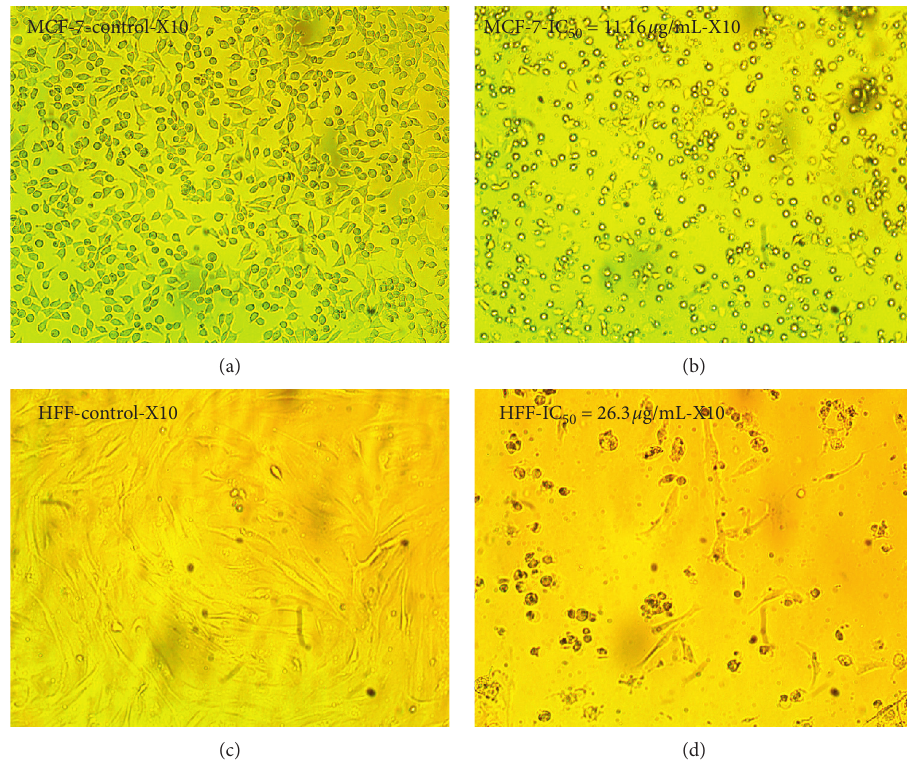
Figure 3: Morphological alteration of cancer cells exposed to the IC 50 (24h) concentration of ZnO-NPs compared with the control. (a) Untreated MCF7 cells. (b) Morphology of the MCF7 cells after ZnO-NP treatment with IC 50 dose (IC 50 � 11.16 μ g/mL). (c) Untreated HFF cell morphology. (d) HFF cells’ morphology after ZnO-NP treatment with IC 50 dose (IC 50 � 26.3 μ g/mL).